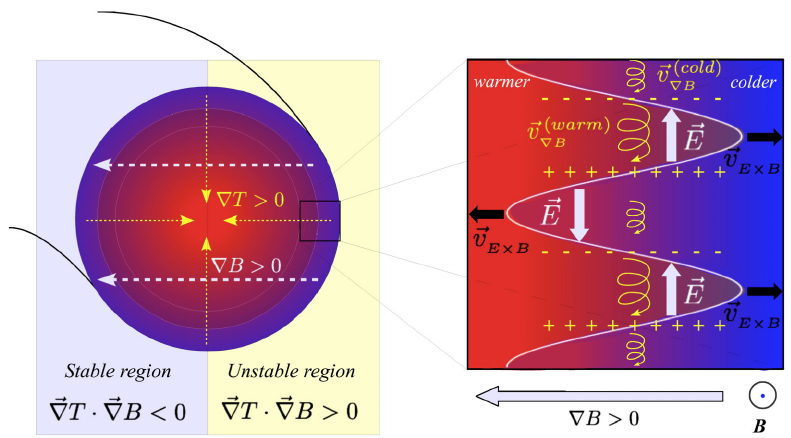
Figure 1. Left frame: sketch of a poloidal section of a tokamak, where the orientation of the gradients of the plasma temperature (yellow dashed arrows) and of the intensity of the magnetic field induction (white dashed arrows) is represented with respect to the curvature of the torus. In the right frame, a cartoon depicts the basic mechanism of the ion temperature gradient (ITG) instability in a portion of the plasma in the unstable region where ∇ T and ∇ B are equally oriented. A harmonic perturbation (white line) in the angular direction mixes warm plasma particles, which have a relatively larger v ∇ B velocity (yellow curled arrows), with colder particles. The difference in velocity is associated to a charge separation and to an angular electric field perturbation (white arrows), oriented so that the corresponding v E × B velocity (black arrows) further increases the amplitude of the harmonic perturbation. The magnetic field toroidal component, which gives the dominant contribution to the E × B velocity, points in the toroidal direction out from the plane, as indicated at the bottom of the right